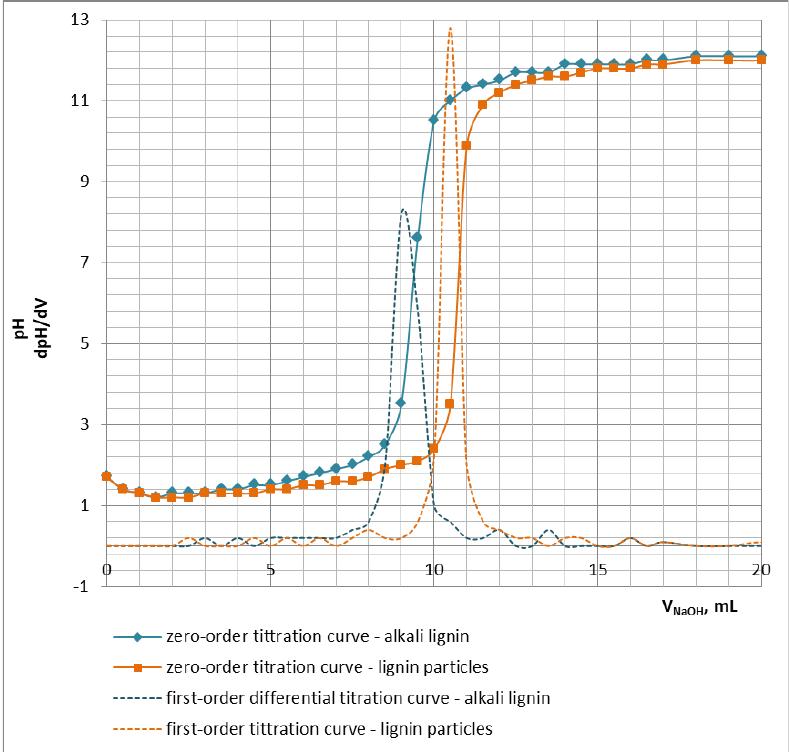
Figure 2. SEM images of ( a ) LP and ( b ) LMP at 50 and 5000 magnifications.